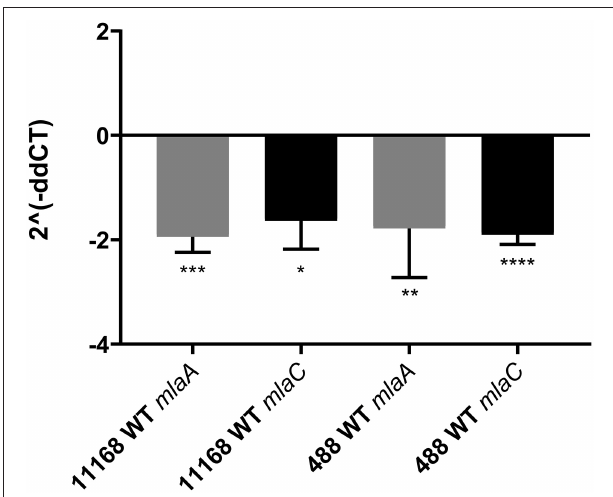
FIGURE 7 | qRT-PCR analysis of mlaA and mlaC transcription in C. jejuni 11168 and 488 wild-type strains co-incubated with 0.2% (w/v) sodium taurocholate. Analysis was performed using mlaA, mlaC, and rpoA gene specific primers. rpoA was used as an internal control. 2 ∧ ( − ddCT ) = fold change in gene expression compared to C. jejuni grown in the absence of ST. * p < 0.05; ** p < 0.01; *** p < 0.001; **** p < 0.0001.